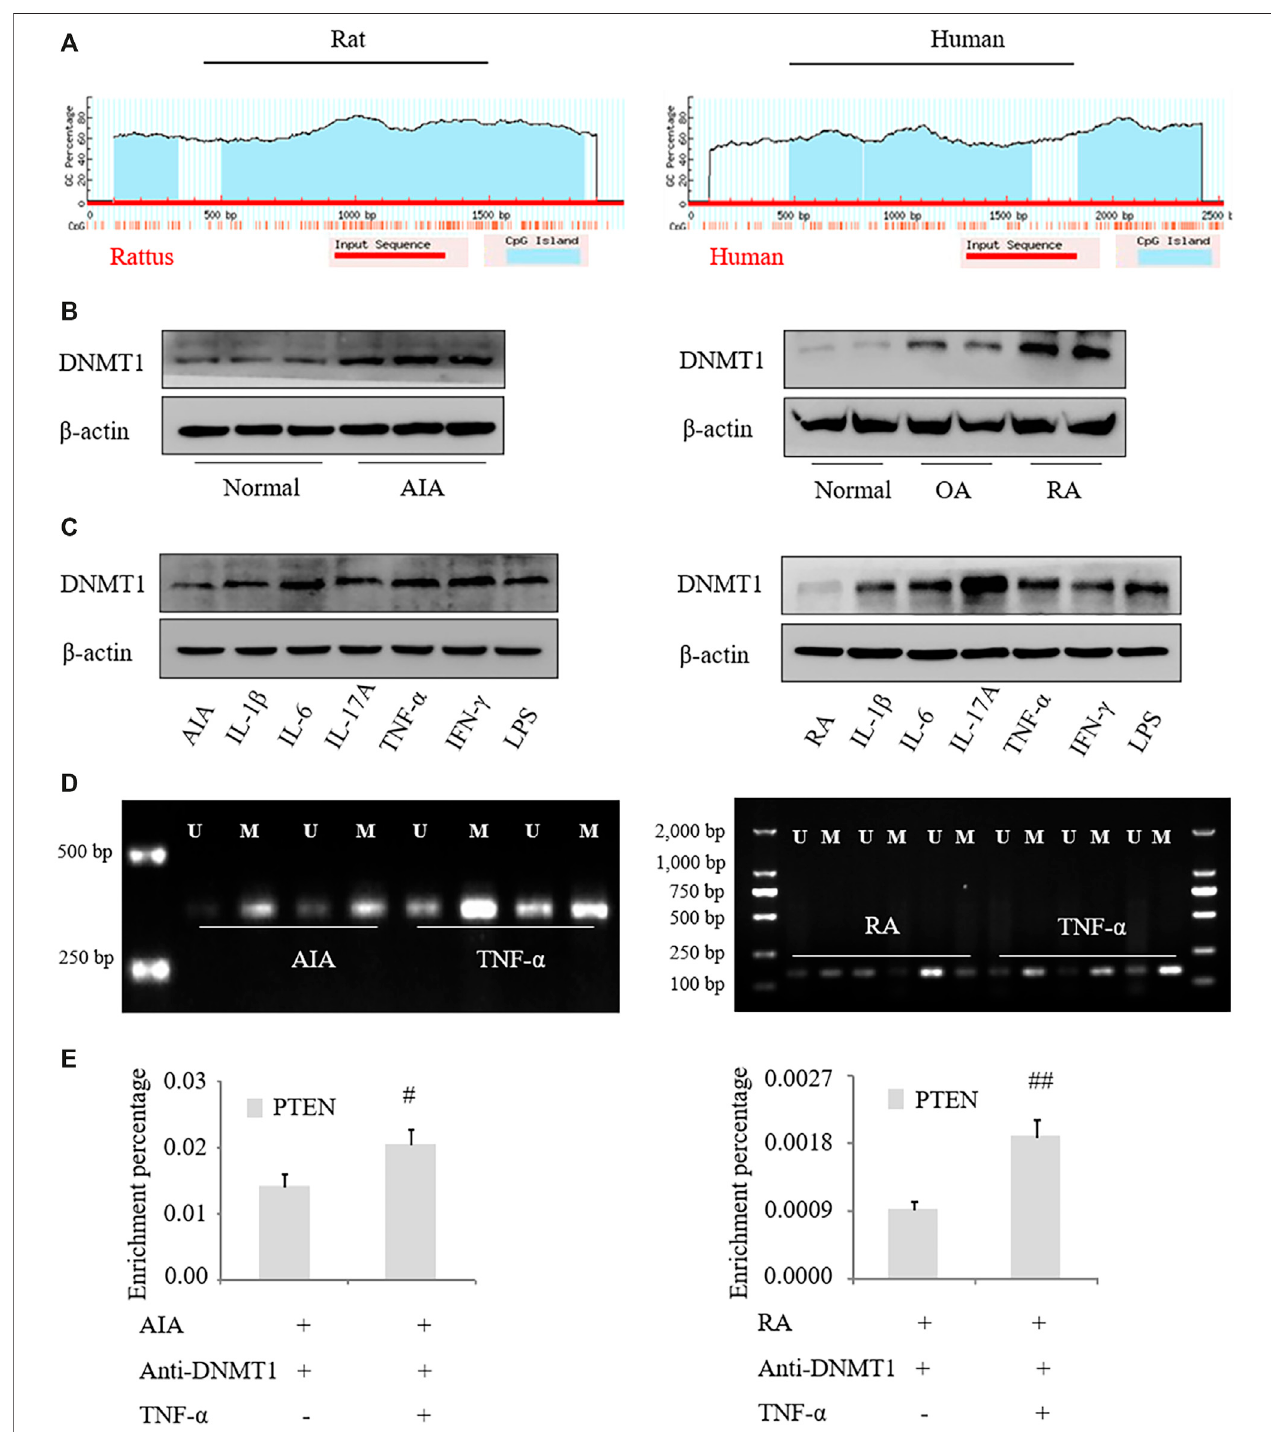
FIGURE2| PTEN expressionisregulatedbyDNAmethylationinRA. (A) Schematicillustrationofratandhuman PTEN genes;aCpGislandwasdetectednearand upstream of the fi rst exon. (B, C) DNMT1 protein expression in FLS from RA patients and AIA model rats was analyzed by western blotting. (D) and after treatment with IL-1 β (2 ng/ml), IL-6 (5 ng/ml),IL-17A(10 ng/ml), TNF- α (10 ng/ml), IFN- γ (10 ng/ml), and lipopolysaccharide (LPS;1 μ g/ml). (D) MSP analysisof PTEN methylationlevel in FLS treated with TNF- α . (E) ChIP of PTEN mRNA precipitated with anti-DNMT1 antibody from FLS treated with TNF- α . Values represent mean ± SD. # p < 0.05, ## p < 0.01 vs. AIA group or RA group.